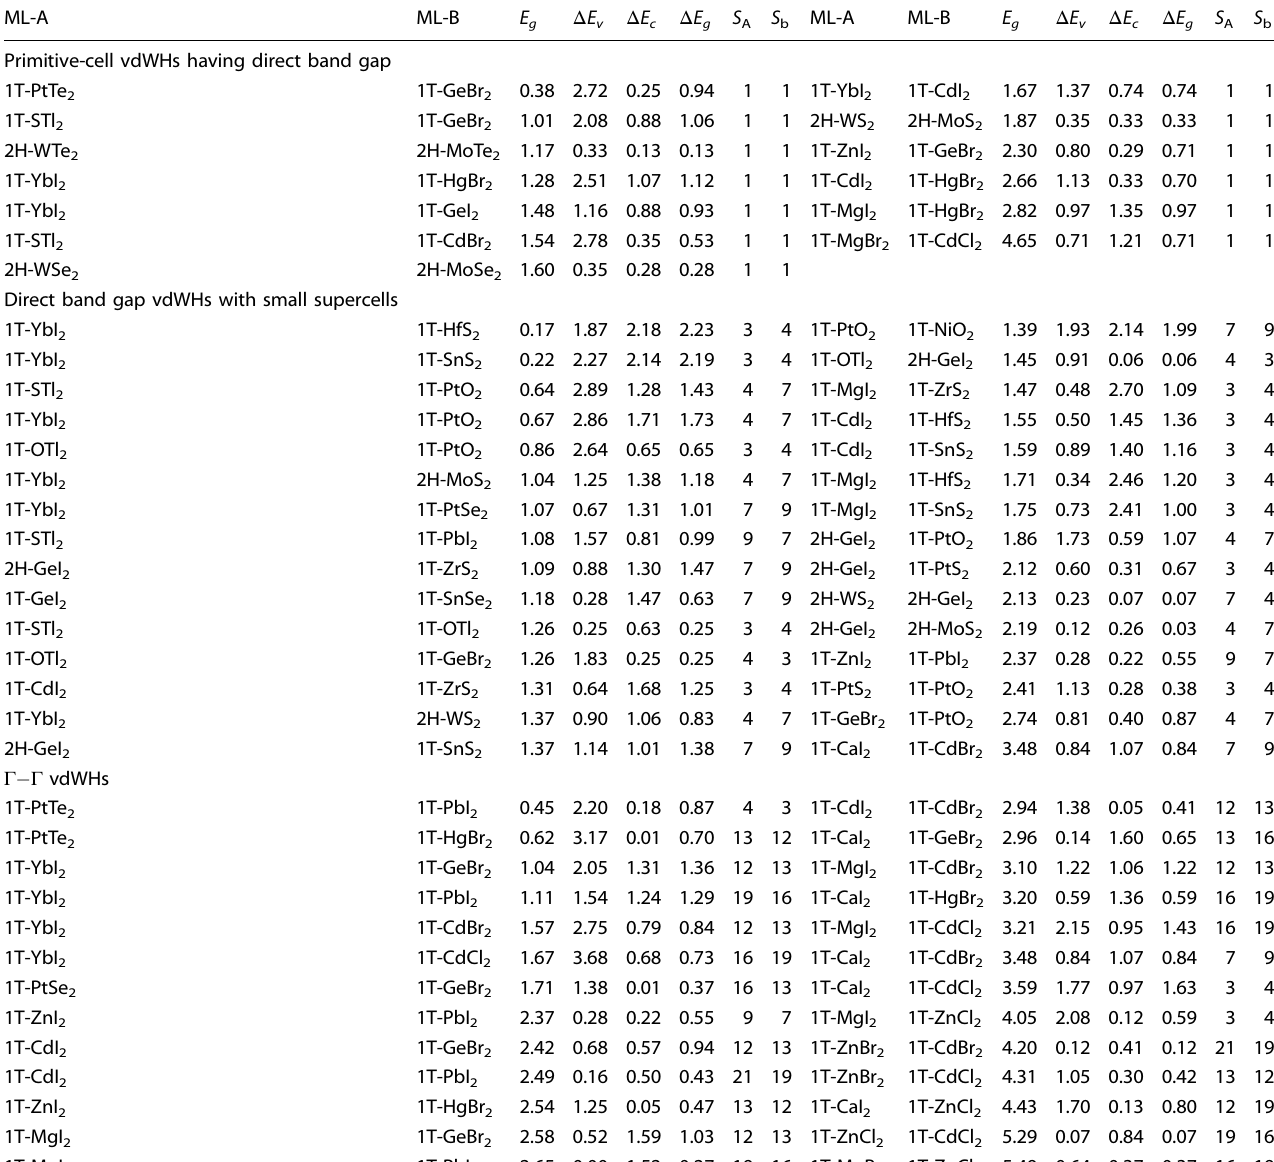
Table 3. Properties of the type-II vdWHs made of 38 nonmetallic MLs and identi fi ed with the non-interacting